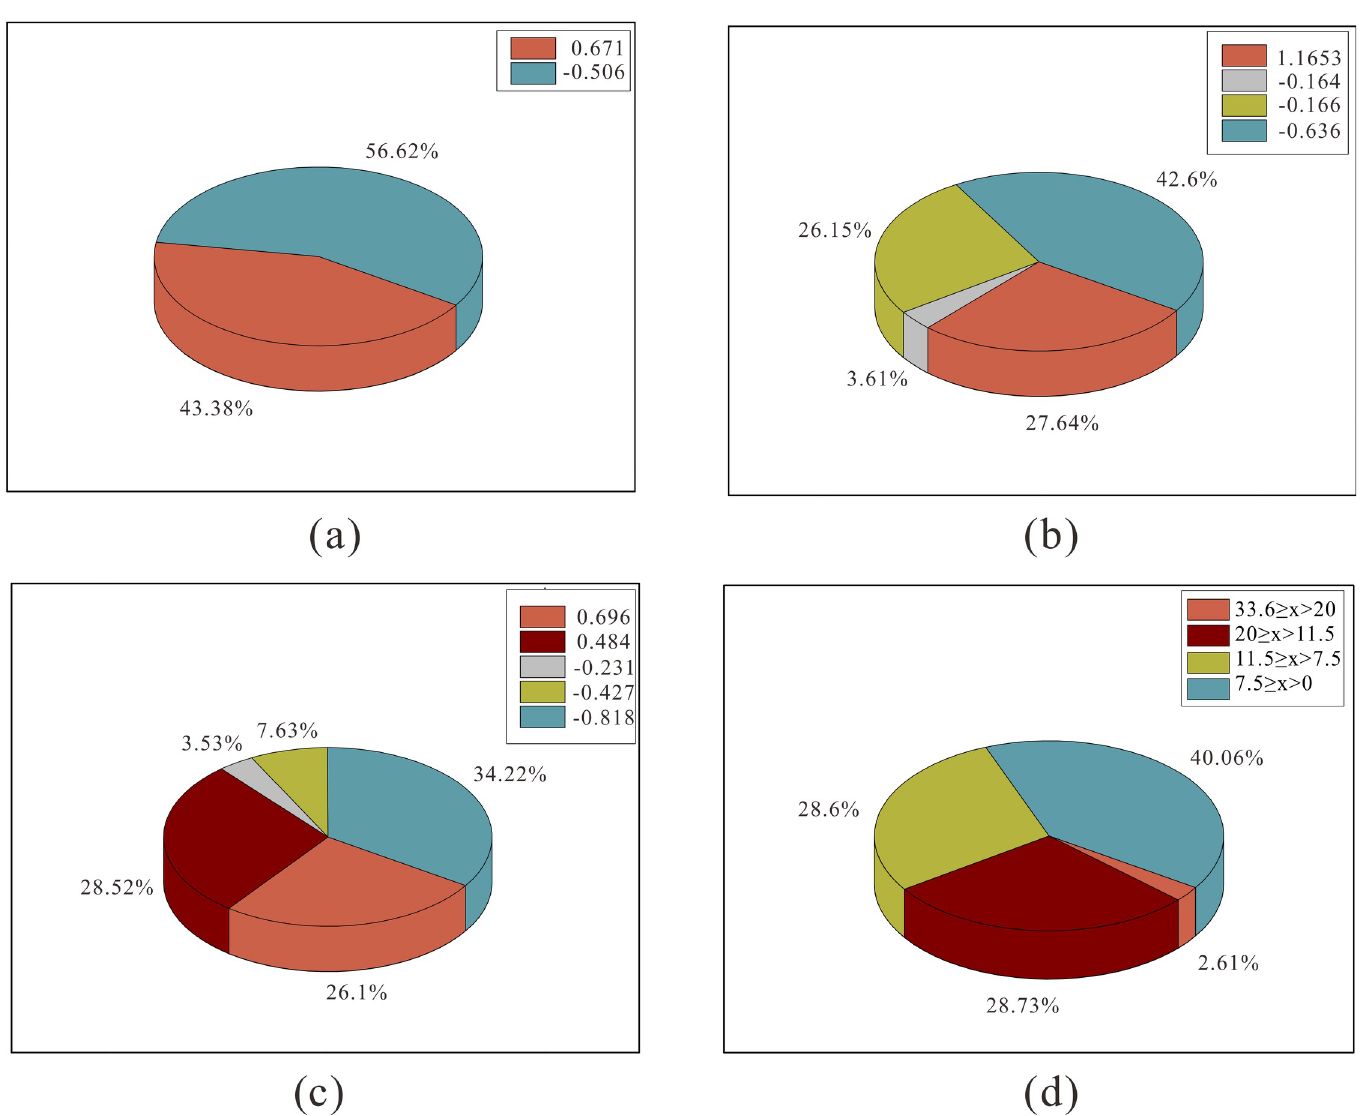
Fig 3. Comparison of system efficiency ratios (a) k = 2, (b) k = 3, (c) k = 4 and (d) raw